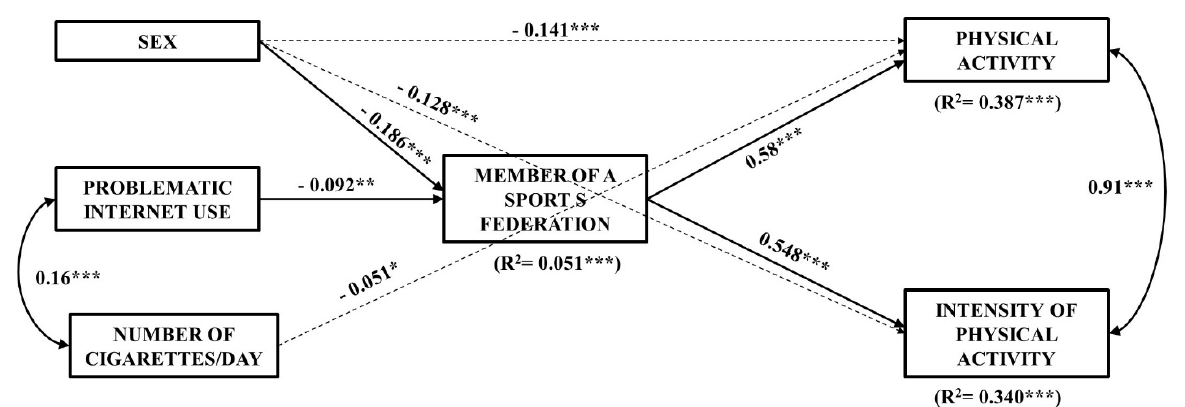
Figure 1. Path analysis model. Direct effects are represented by continuous arrows; indirect effects are represented by dashed arrows. The β values are shown next to each arrow. * p < 0.05; ** p < 0.01; *** p < 0.001.